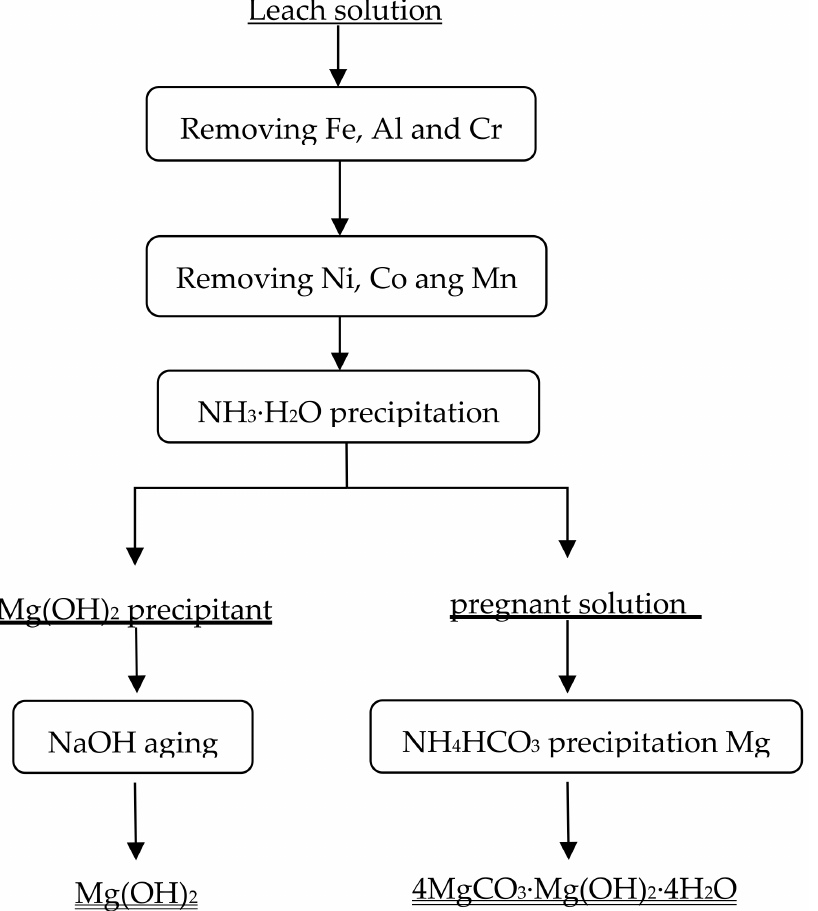
Figure 1. The process flowchart of serpentine mineral resource to prepare high purity Mg(OH) 2 and 4MgCO 3 · Mg(OH) 2 · 4H 2